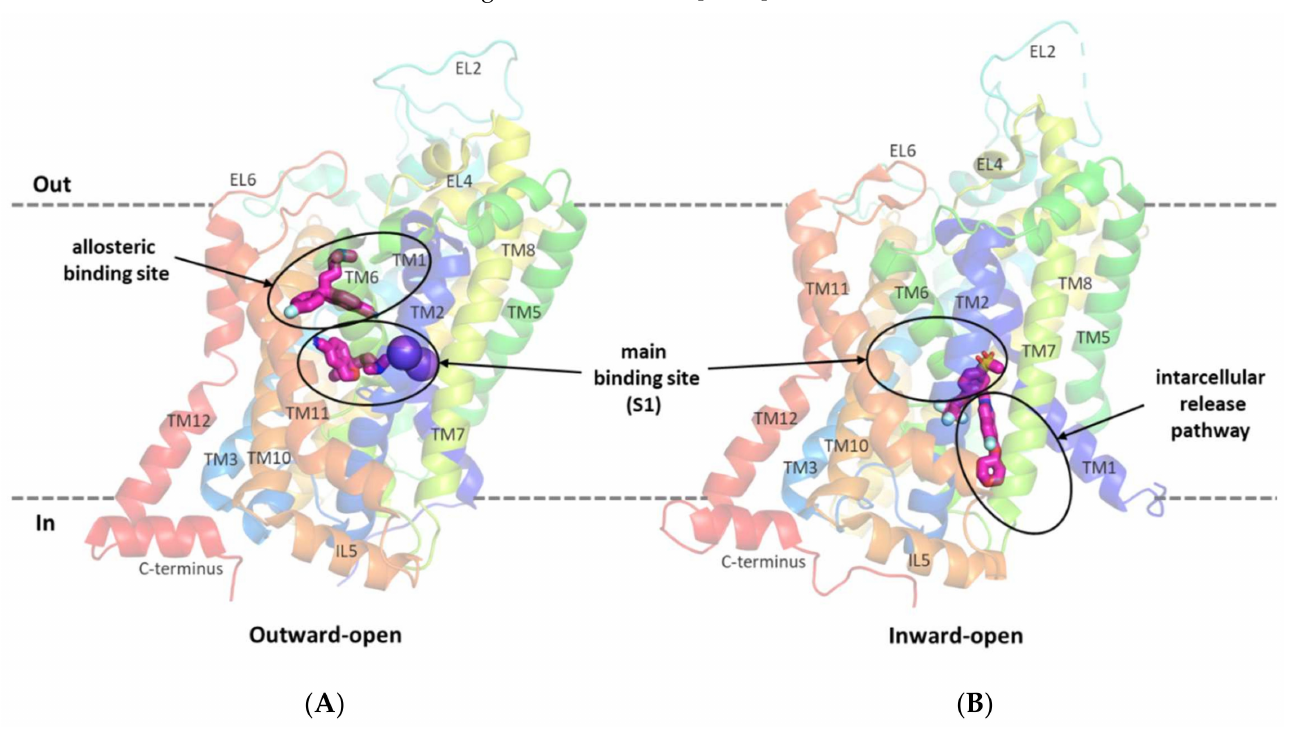
Figure 3. SERT in an outward-open state in complex with s-citalopram at the main and allosteric binding sites (PDB code: 5I73) ( A ). GlyT-1 transporter in an inward-open state in complex with a bitopertin analog (compound 1 ) located partially within the intracellular glycine release pathway (PDB code: 6ZBV) ( B